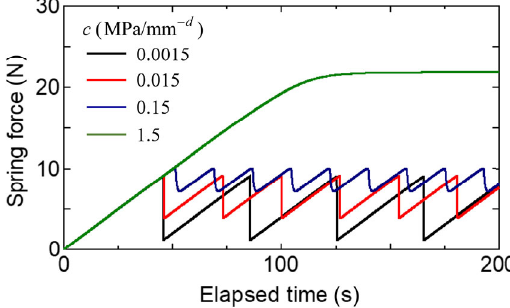
Fig. 9 Variations of spring force with elapsed time for various rate-dependencies of shear strength 